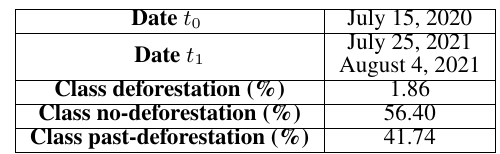
Table 1. Image acquisition dates and class distribution of the study